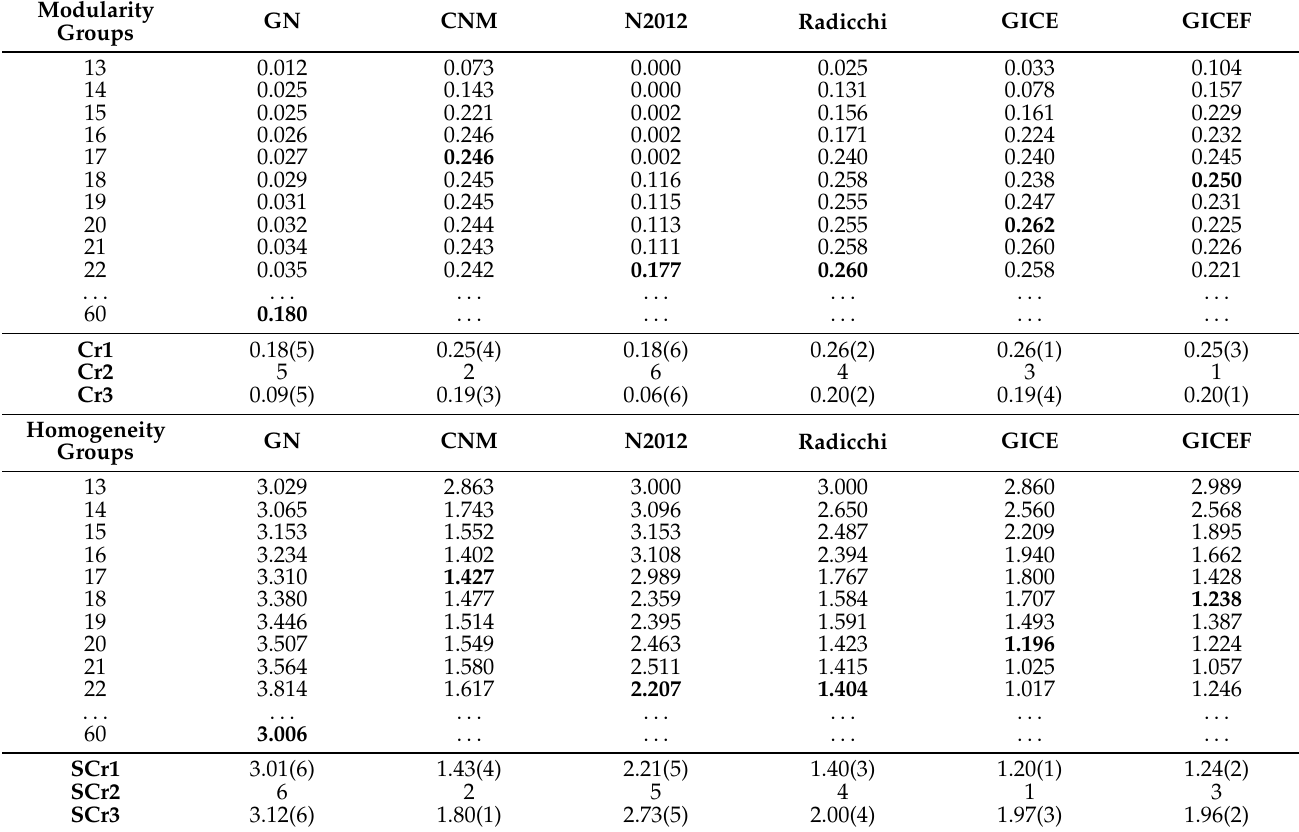
Table 5. Modularity and Homogeneity for partitions with k groups ( k = 13, . . . ,60) obtained using the GN, CNM, N2012, Radicchi, our GICE and its fast version (GICEF) for the authors network. The criteria values are shown in parentheses. Modularity Groups